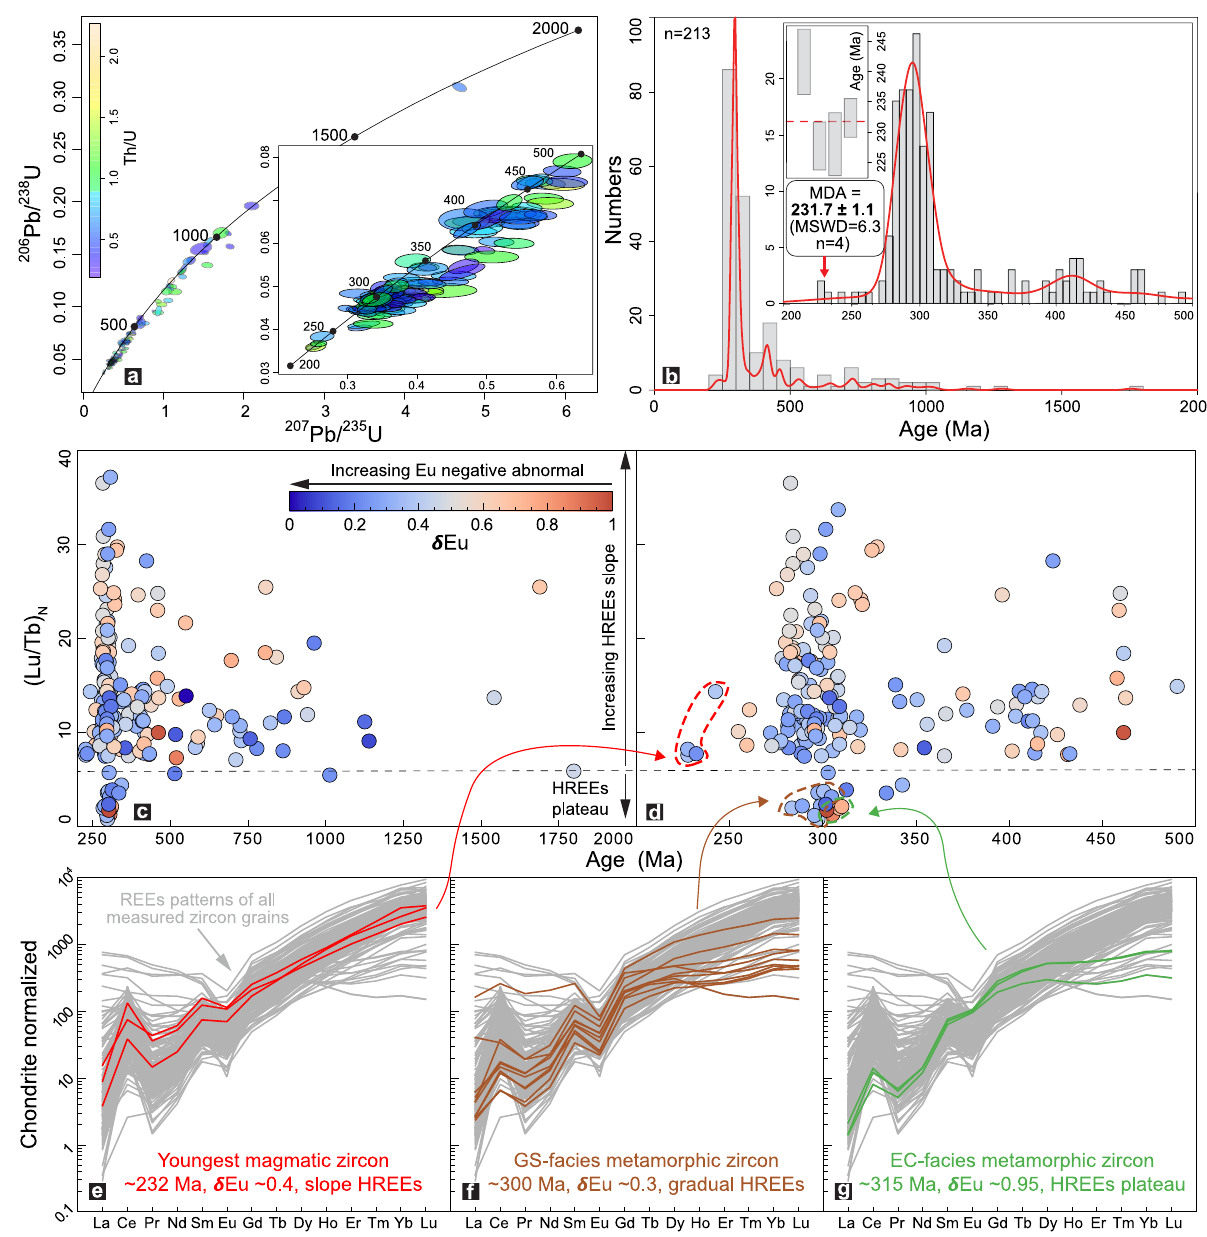
Fig. 4 Detrital zircon U-Pb isotopic and rare earth elements (REEs) results. a , b Detrital zircon U-Pb concordia and KDE plots of the MFAB sandstones. c – g Diagrams of ages versus detrital zircon rare earth elements characters (denoted by δ Eu, (Lu/Tb) N , and REEs pattern) to deduce the multiple detritus